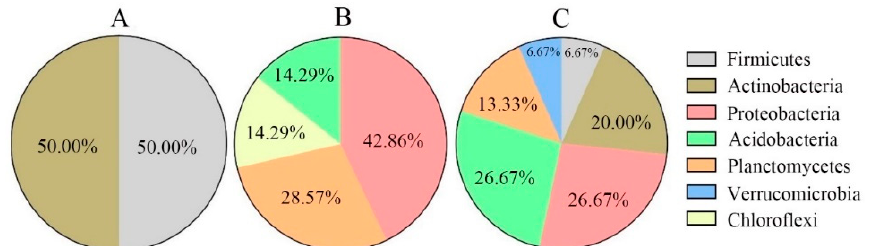
Figure 4. Distribution patterns of key phylum in topsoil ( A ), middle layer ( B ), and subsoil ( C ) of native tree plantation.